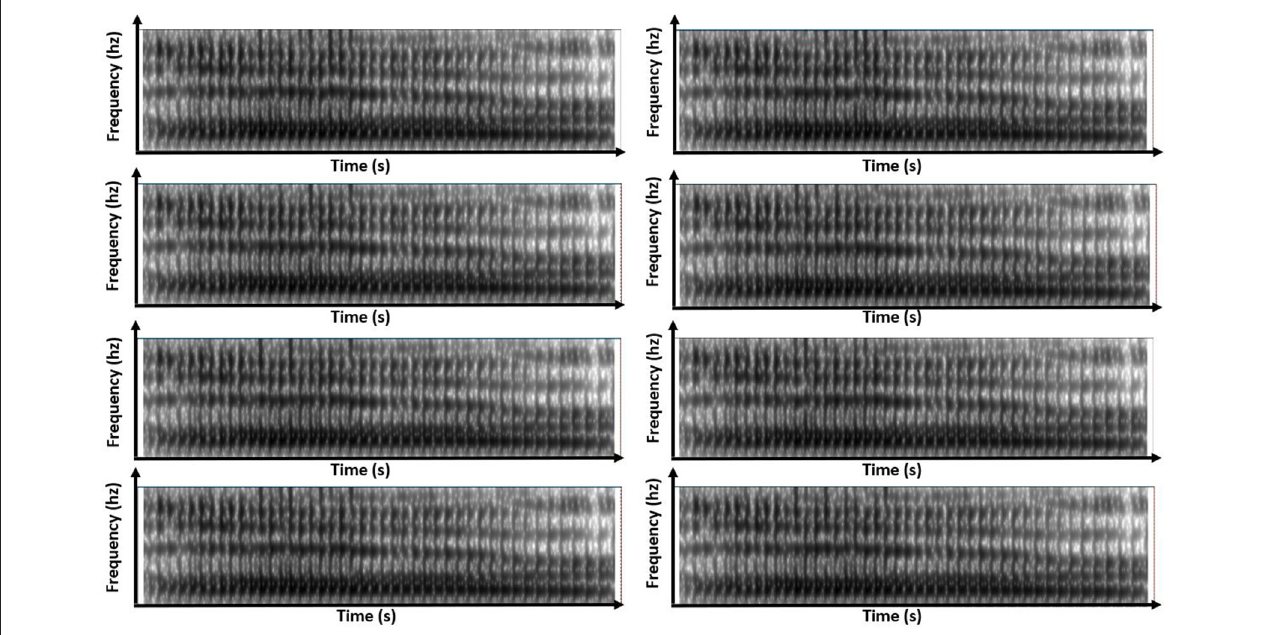
FIGURE 5 | Eight panels of spectrograms for each of the eight variants of simulated-speech contexts simulating the speech context “[a ô ]”.